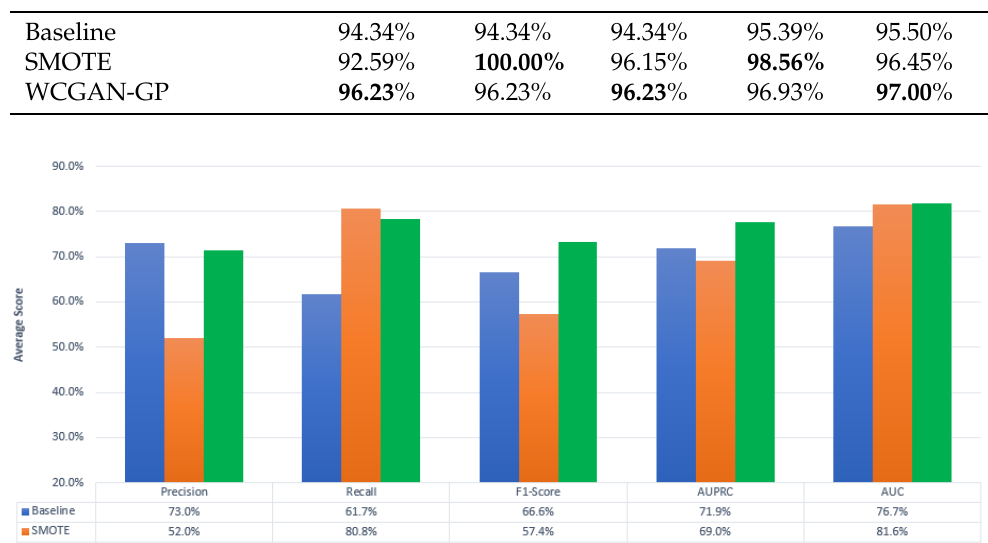
Figure 6. Average performance across all data